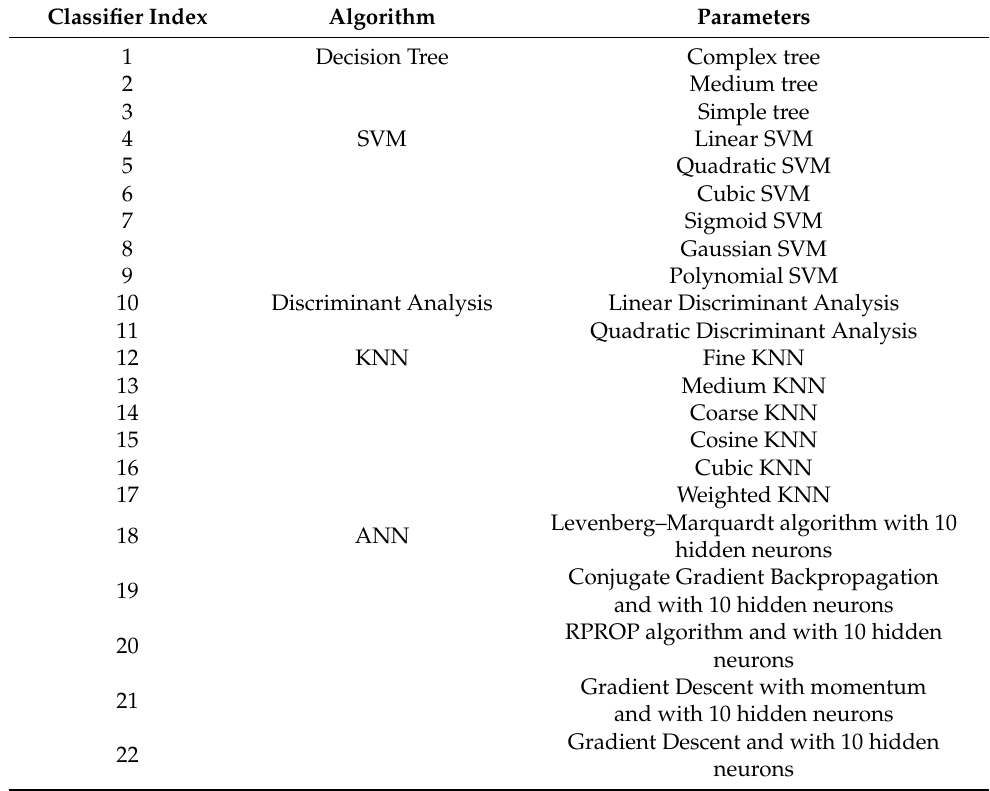
Table 4. Machine Learning Classifiers.